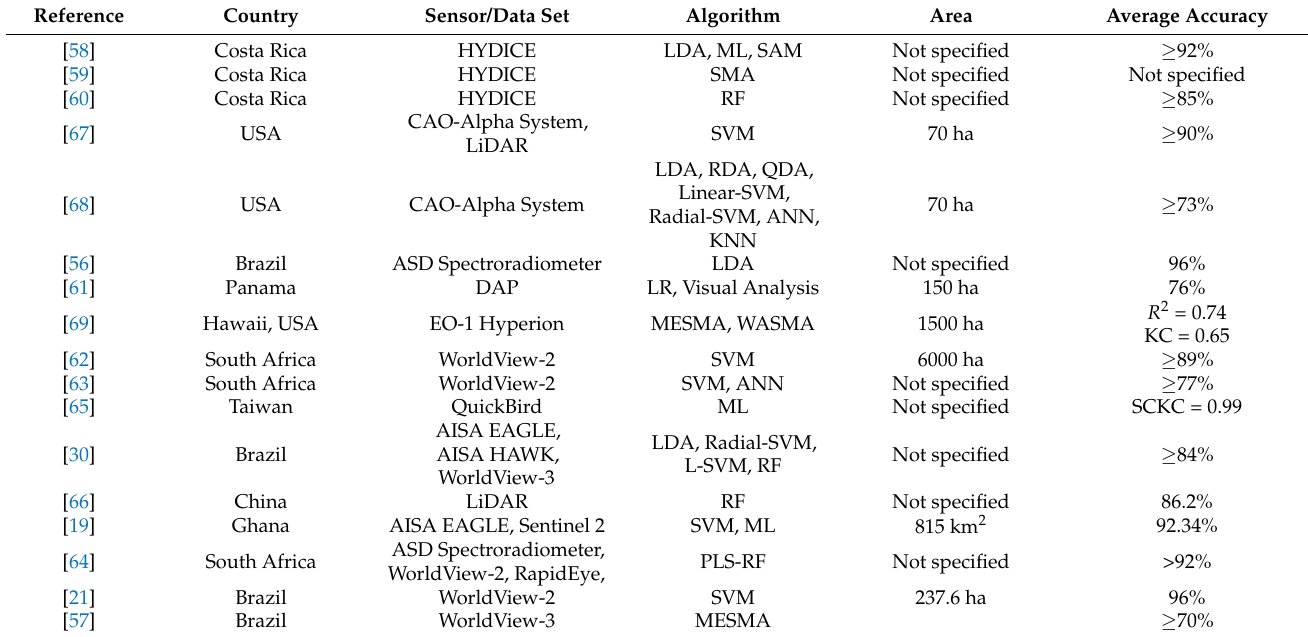
Table 2. Tree species identification using remote